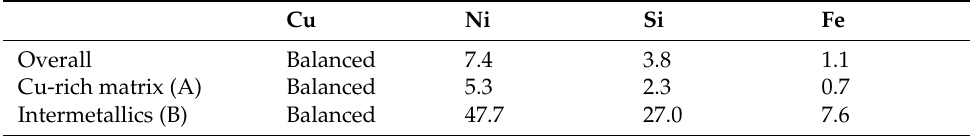
Figure 2. Microstructures of Cu 86.5 alloy aged at 500 ◦ C for 1 h: ( a ) SEM image (A: Curich matrix and B with arrow: intermetallics) and ( b ) X-ray diffraction pattern. Table 1. Composition of Cu 86.5 alloy aged at 500 ◦ C for 1 h